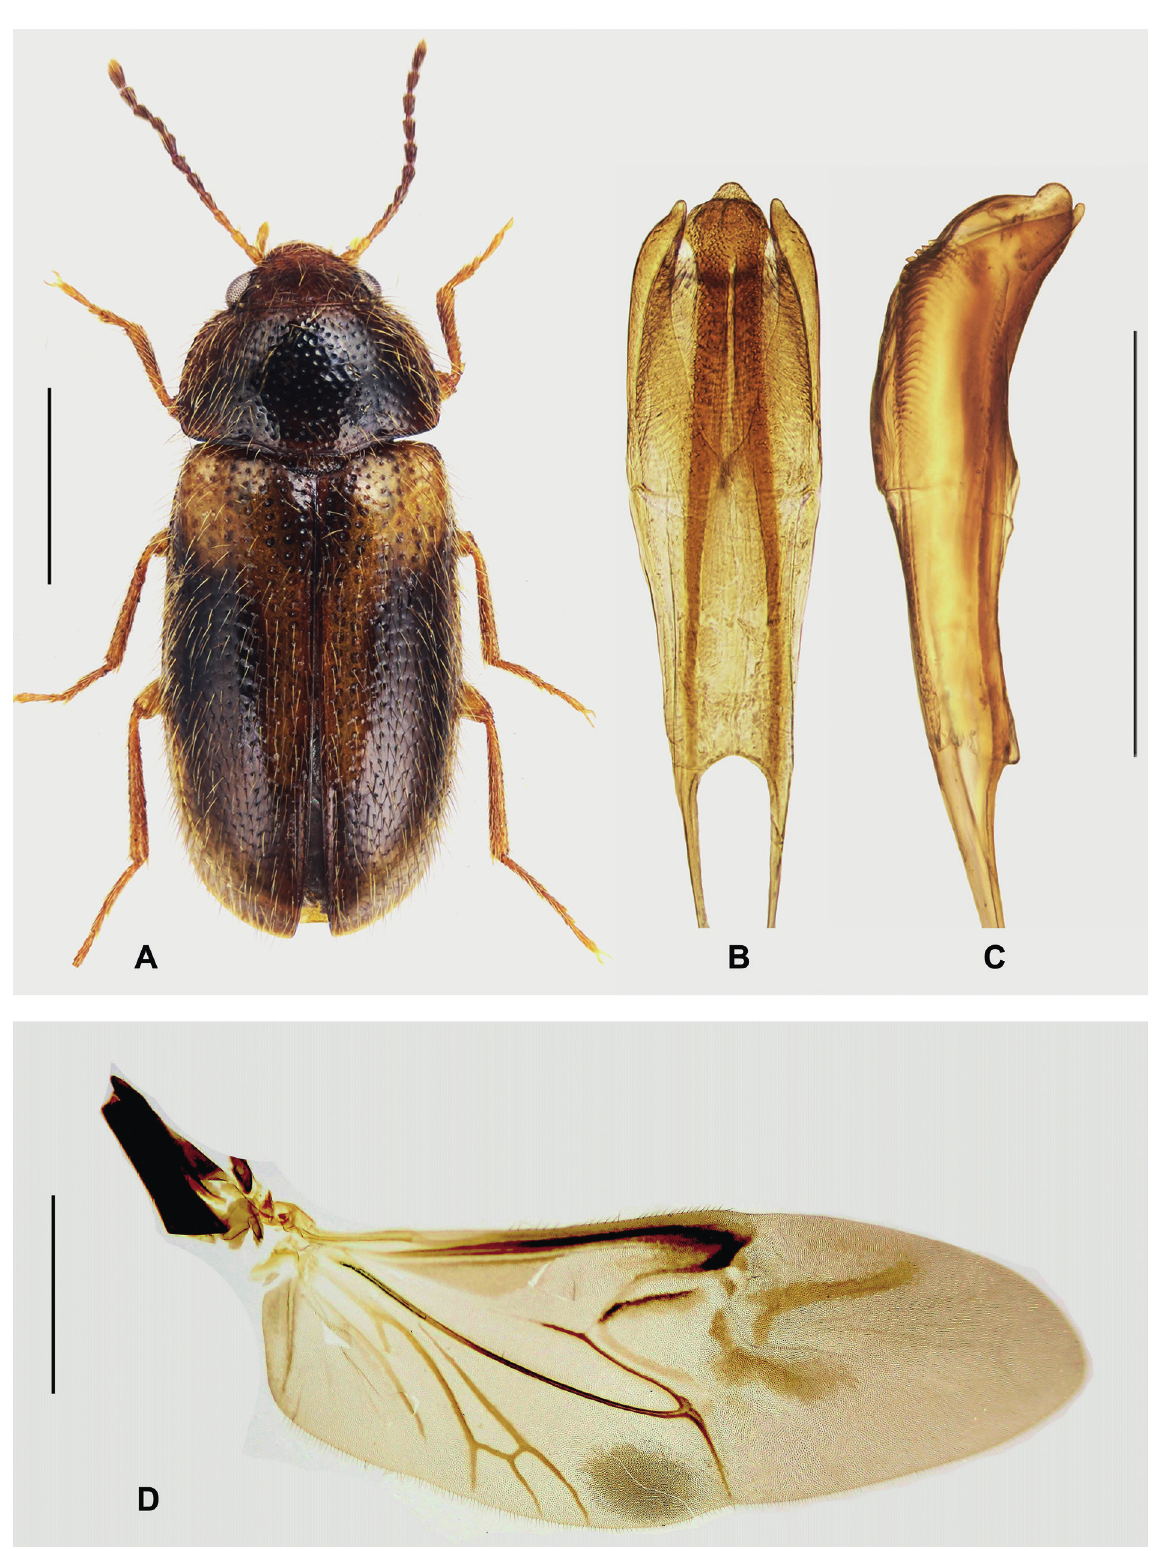
Fig. 1. Stereophilus filicornis (Reitter, 1887) gen. et comb. nov., ♂ from Italy, Tuscany. A . Habitus. B . Aedeagus (dorsal view). C . Aedeagus (lateral view). D . Right hind wing of a male from France, Haute-Garonne. Scale bars: A, D = 1 mm; B–C = 0.5